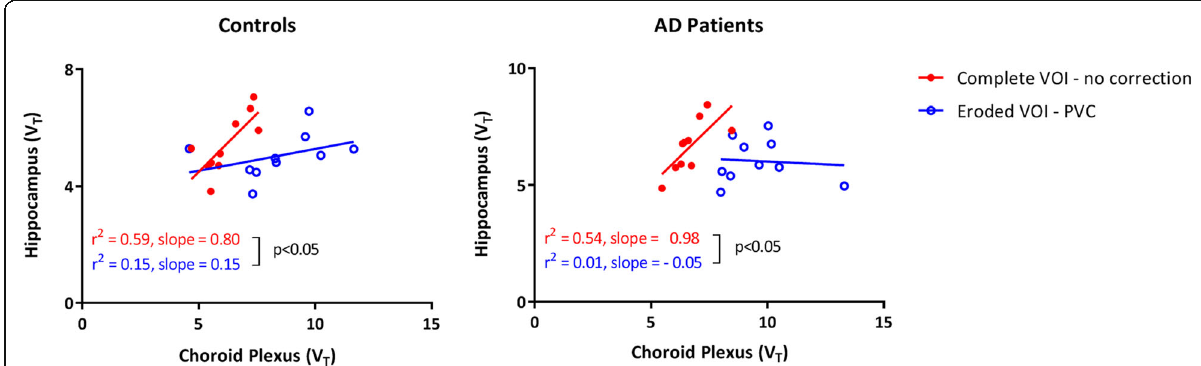
Fig. 2 Scatter plots illustrating the relationship between hippocampus V T and choroid plexus V T before (red) and after (blue) using both PVC and an eroded hippocampal VOI for controls (left) and probable AD patients